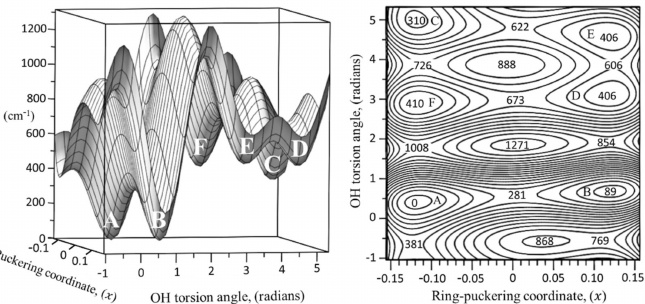
Figure 6. Potential energy surface (PES) and contour map of 2CPOL in terms of its ring-puckering and the OH internal rotation